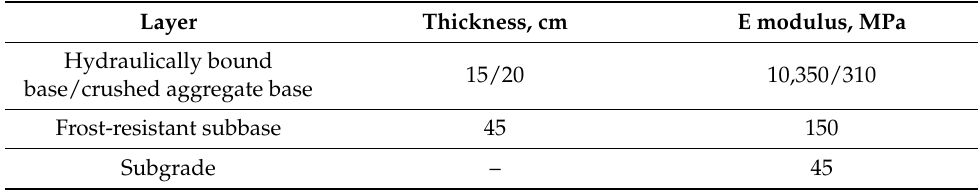
Table 4. Theoretical pavement structure layers below PCP slab.